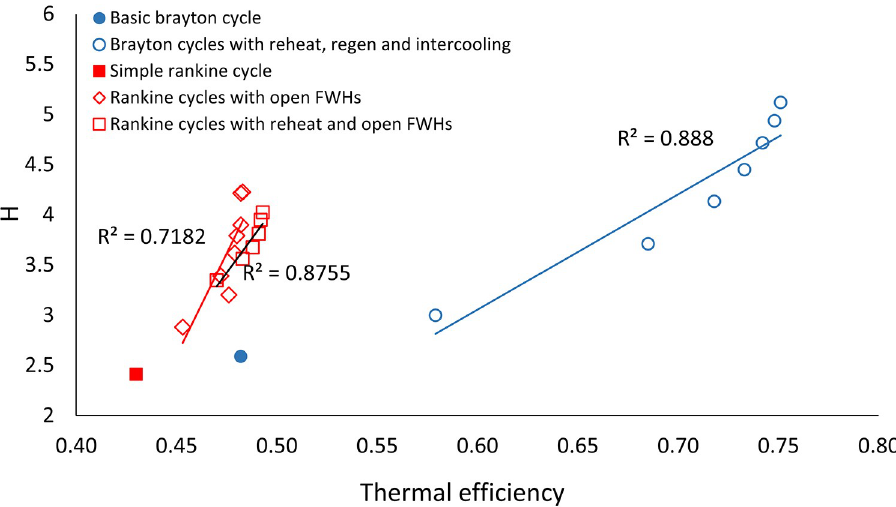
Fig 7. Thermal efficiency plotted against Shannon Index ( H ) for the three sets of thermodynamic cycle improvements.